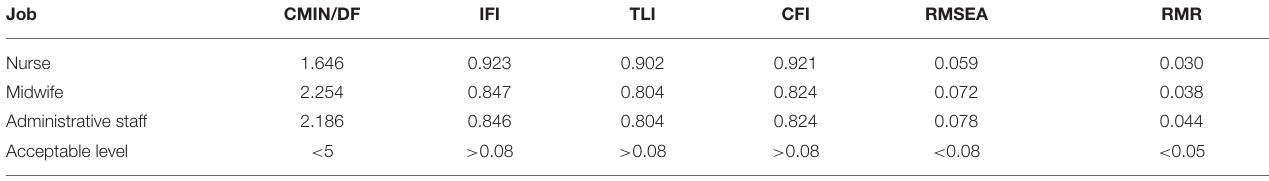
TABLE 5 | The relationship model between mental workload and job satisfaction by considering the job control variable by occupational groups. Job CMIN/DF IFI